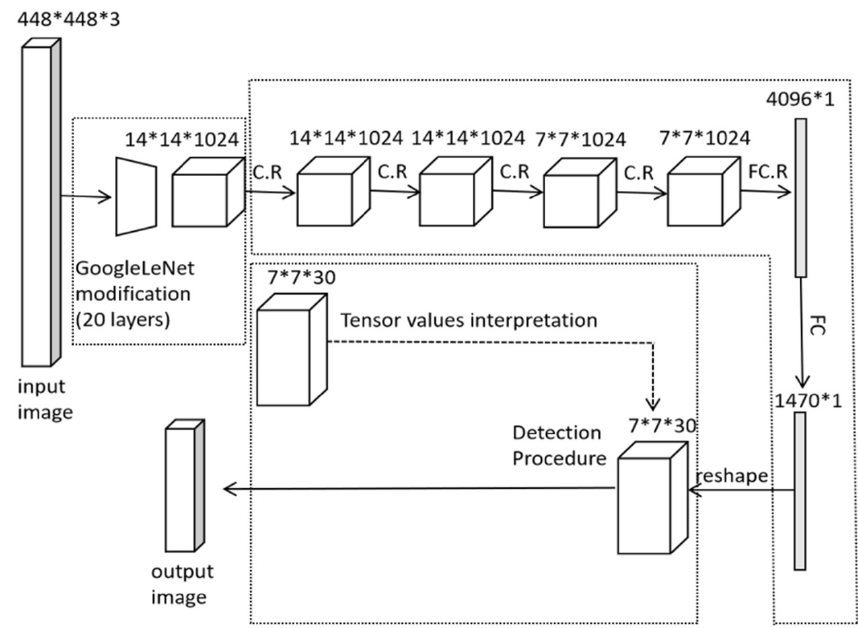
Figure 4. The block diagram of the YOLO network.